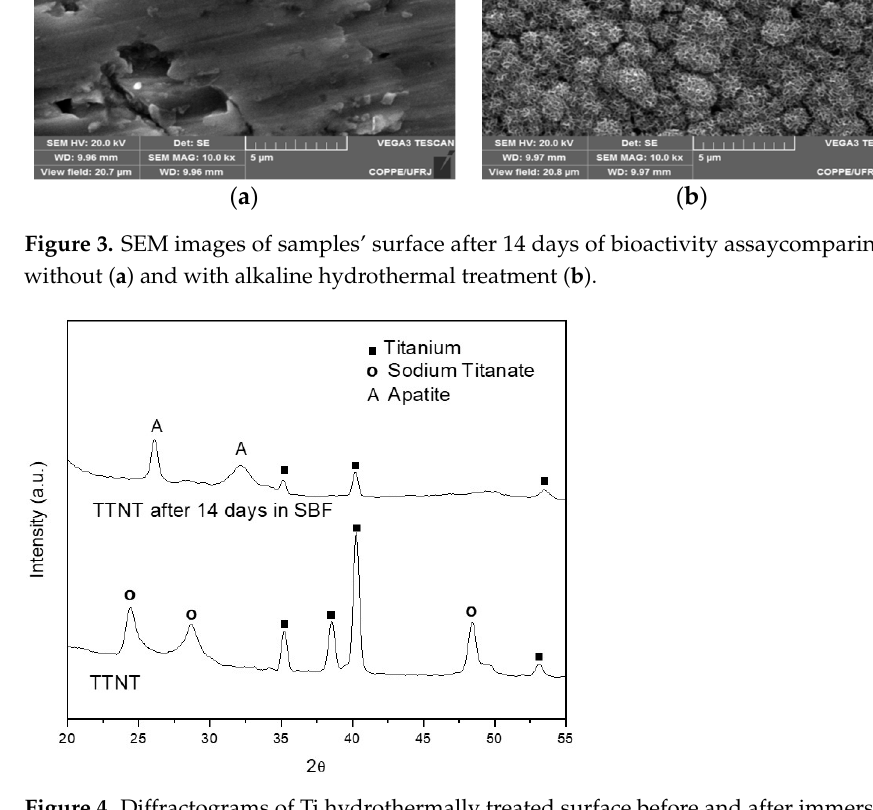
Figure 4. Diffractograms of Ti hydrothermally treated surface before and after immersion in SBF for 14 days.